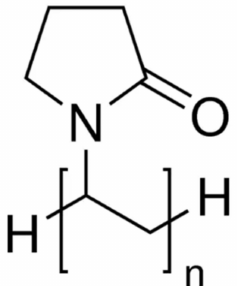
Figure 10. Two-dimensional structure of N-vinyl piperidone